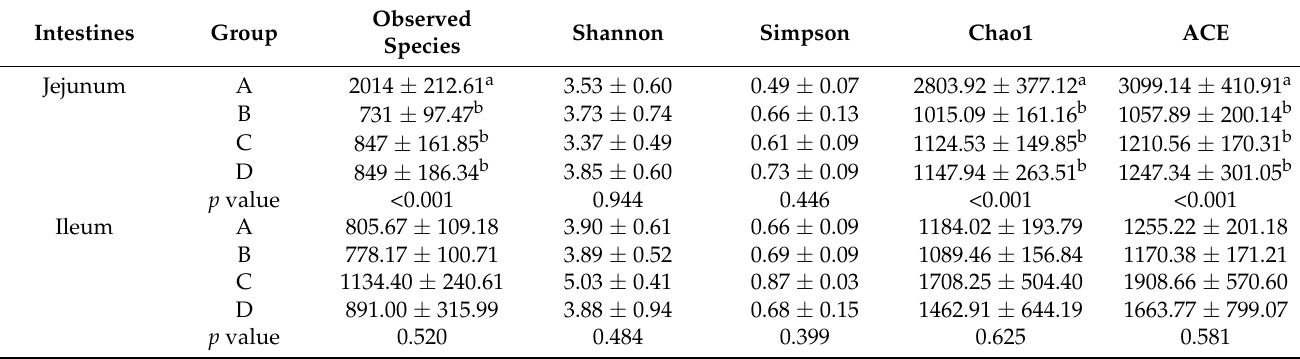
Table 4. The alpha diversity analysis of microbiome in the jejunum of the geese at the age of 70 days. Observed Shannon Simpson Chao1 ACE Intestines Group Species Jejunum